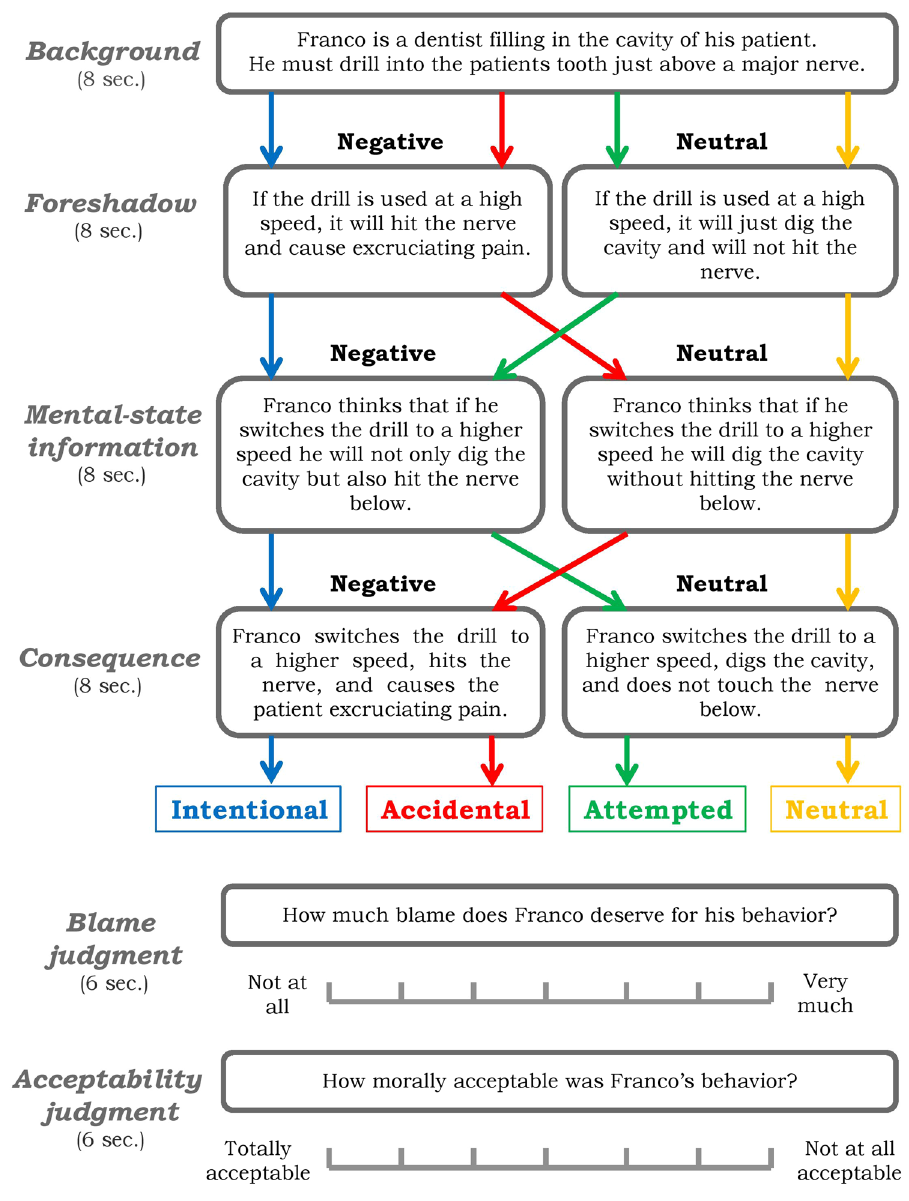
Figure 5. Experimental stimuli and design. Each moral vignette consisted of the following text segments: a background stem providing set-up for the story, a foreshadow segment that foreshadowed the nature of outcome, a mental-state information segment that provided information about actor’s belief, a consequence segment that described action and its outcome. These segments were then followed by questions assessing acceptability and blame